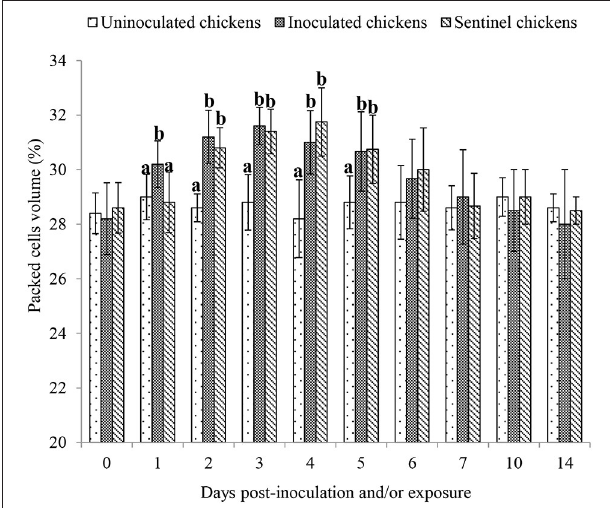
FIGURE 1 | Mean packed cell volume of chickens following inoculation with and/or exposure to a very virulent infectious bursal disease virus. Values with different alphabets in the same day differ significantly at P <